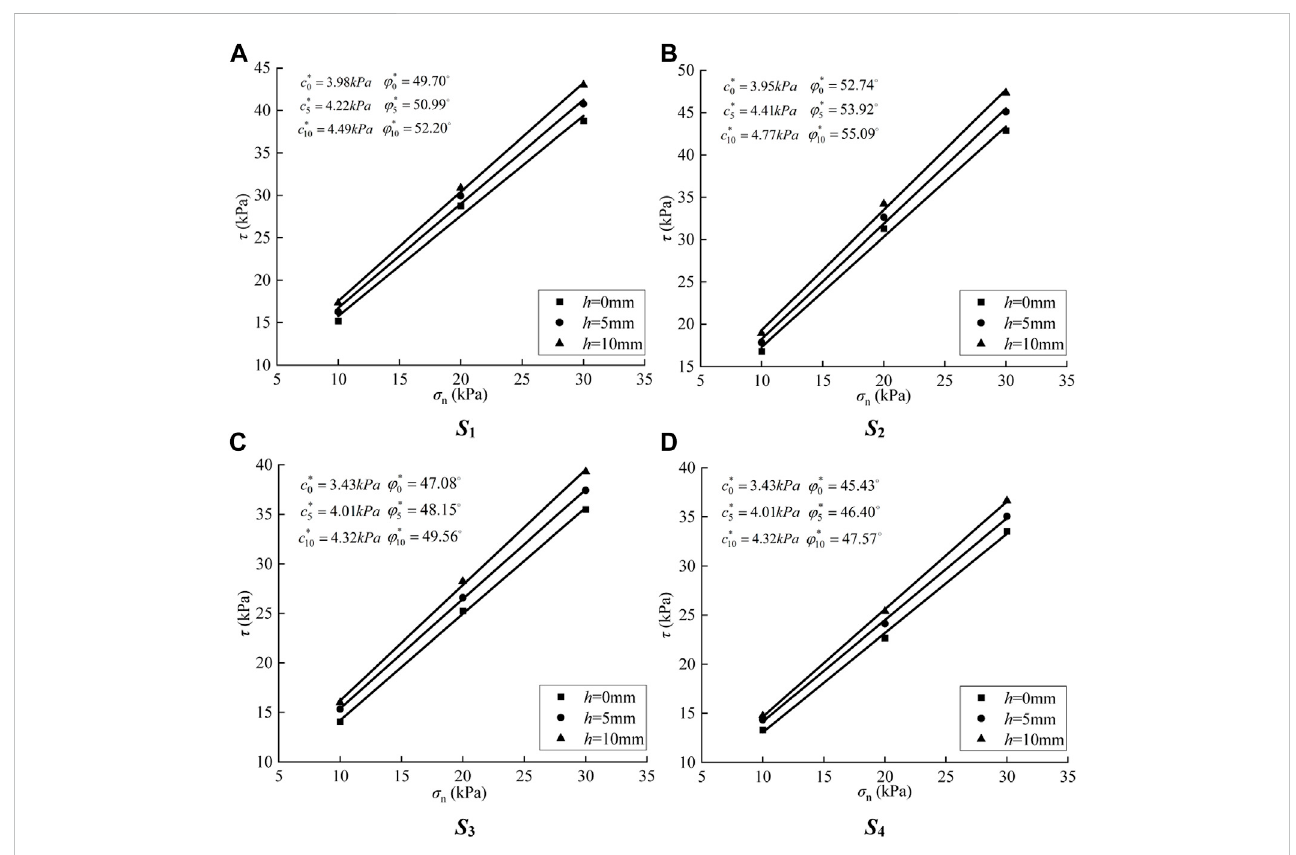
FIGURE 6 τ ~ σ n curve of the warp-knitted toothed